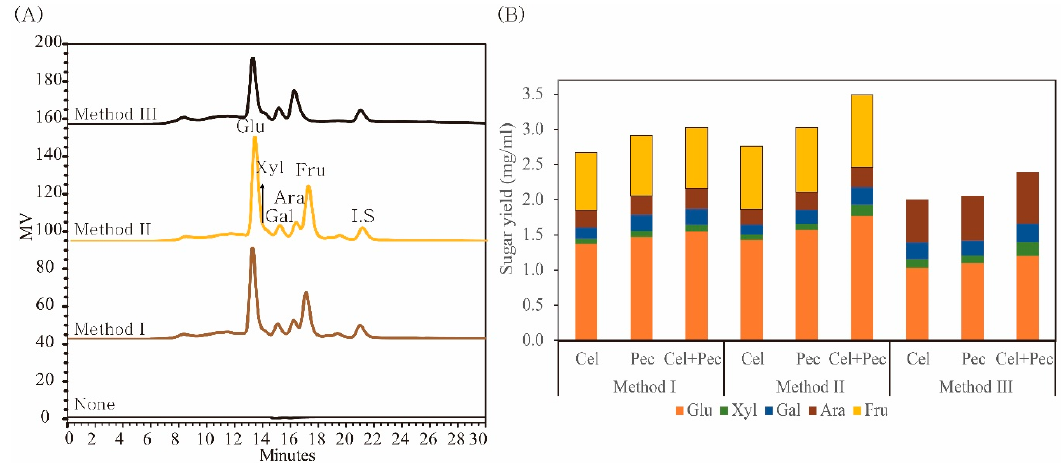
Figure 4. ( A ) HPLC spectra sugar yields obtained using different methods, and ( B ) the synergistic effect of cellulase and pectinase on MPW with each method. Glu: glucose, Xyl: xylose, Ara: arabinose, Fru: fructose, Gal: galactose, I.S.: internal standard, Cel: cellulase, Pec: pectinase.